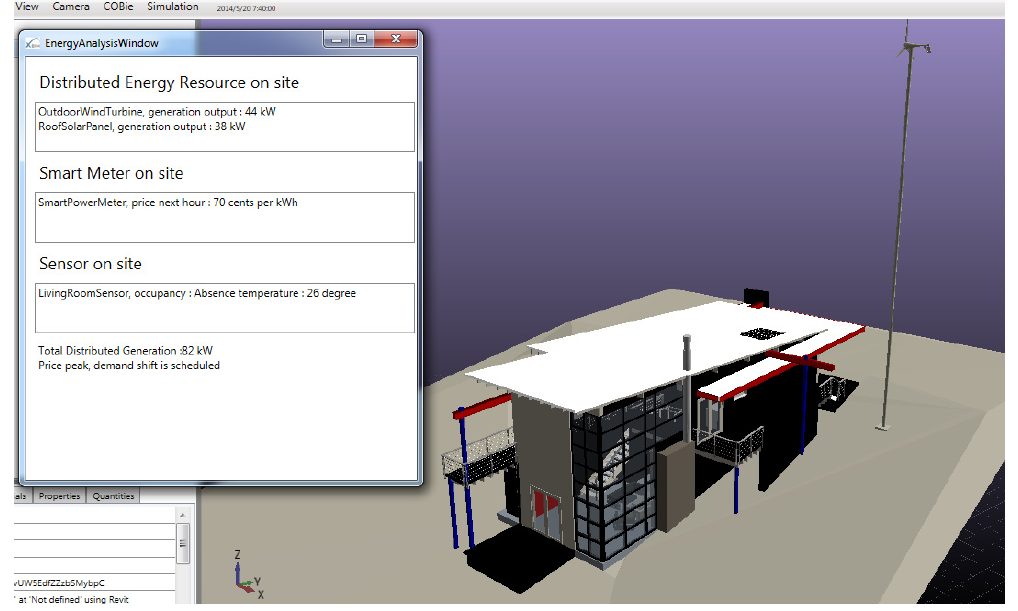
Figure 11. Energy analysis functionality in smart built